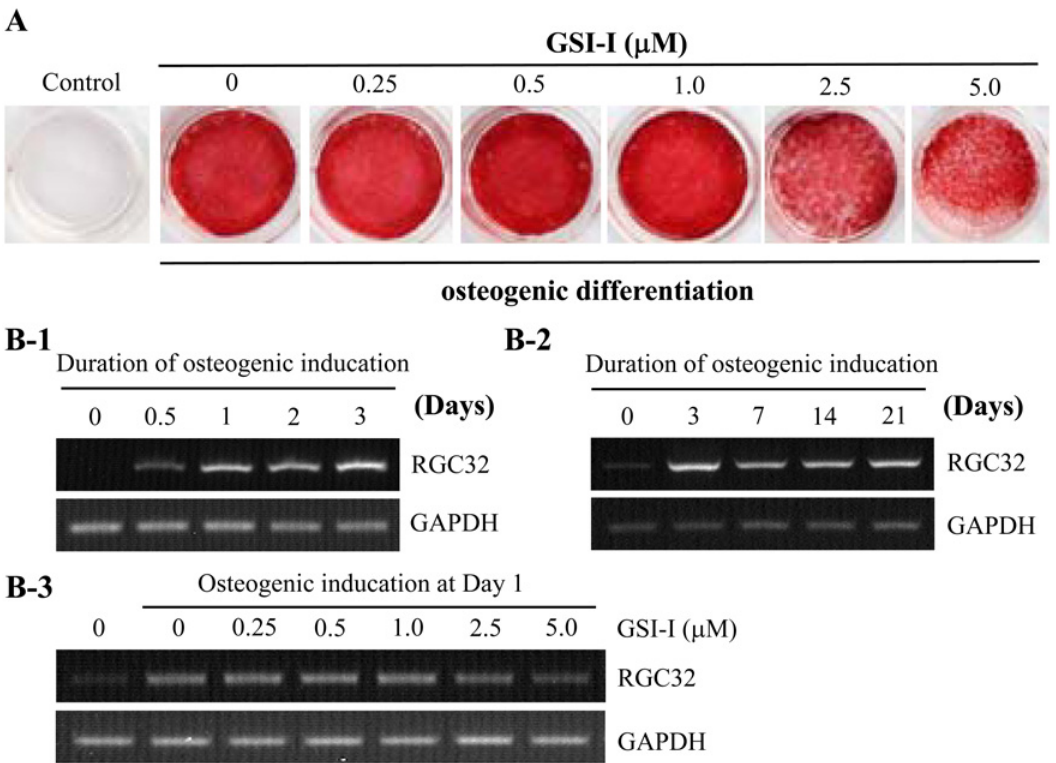
Fig 3. The GSI-I treatment reduces osteogenesis of hUC-MSCs. A. The treatment inhibits intracellular calcium deposition as detected by Alizarin Red staining at 14 d after osteogenic induction. B. The semi-quantitative RT-PCR shows that the osteogenic induction induces RGC32 gene expression starting at 12 h and reaching to a plateau at day 3 (B-1, B-2). However, the GSI-I treatment with greater than 2.5 μ M GSI-I significantly reduces RGC32 transcription at 24 h after treatment (B-3). The cells without osteogenic induction serve as negative